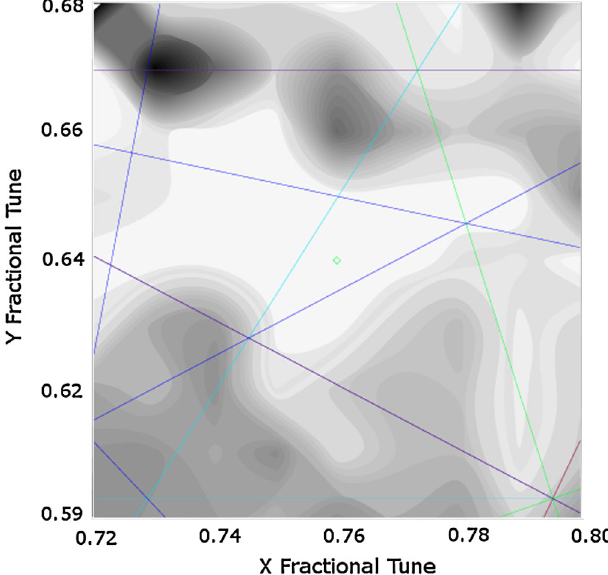
order.FIG. 4. A plot of the closed orbits for one operating point both horizontally and vertically.